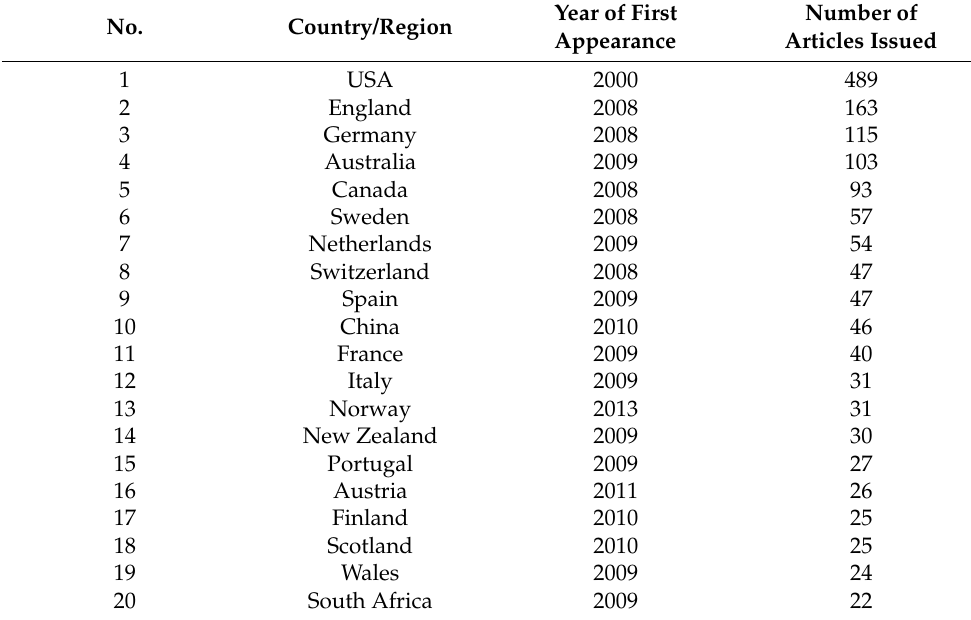
Year of First Number Appearance